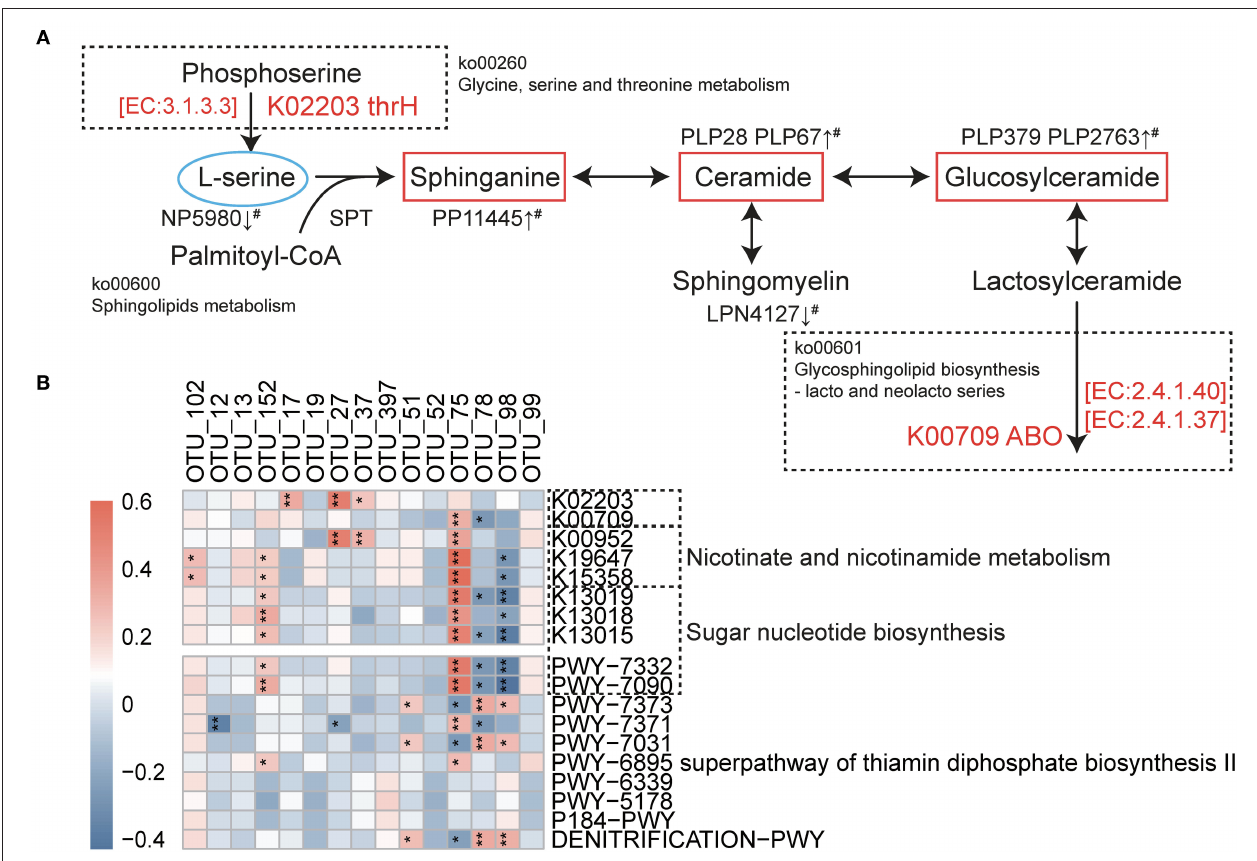
FIGURE 4 | Association between predicted metagenomic functional changes and differential OTUs as well as sphingolipids metabolism. (A) Relationship between sphingolipids pathway and two related differential enzymes (K02203 and K00709) predicted by PICRUSt2. The features are highlighted in red (smoking-positive) or blue (smoking-negative). # Observed metabolomic changes in smokers with CAD compared with never smokers in the present study. IDs and names of enzymes and pathways were based on the KEGG database. SPT, serine pamitoyl-transferase; K02203, homoserine phosphotransferase; K00709, histo-blood group ABO system transferase. (B) Spearman correlations between smoking-associated OTUs and metagenomic prediction including differential pathways as well as important enzymes. IDs of enzymes were according to the KEGG database; IDs of pathways were according to the MetaCyc database. * p < 0.05, ** p < 0.01.